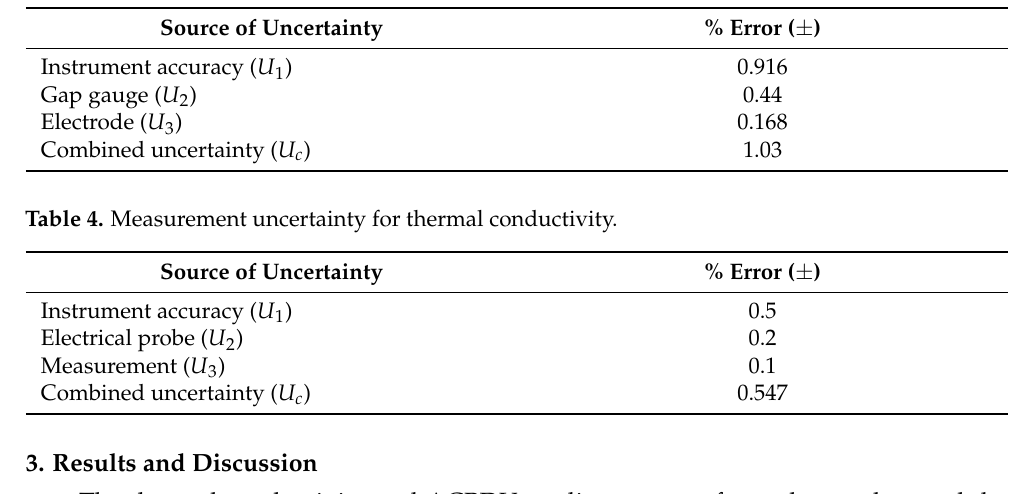
Table 3. Measurement uncertainty for ACBDV.